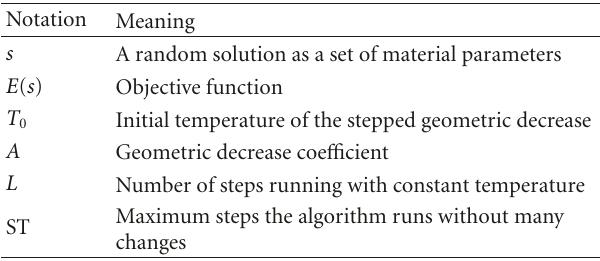
Table 1: Simulated annealing algorithm parameters.